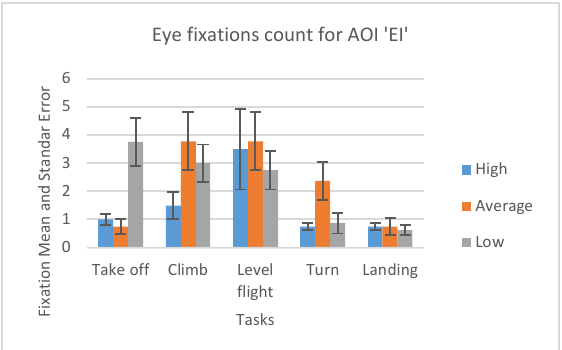
Figure 16. Number of fixations AOI ‘EI’ for five flight phases for psychological selection stream